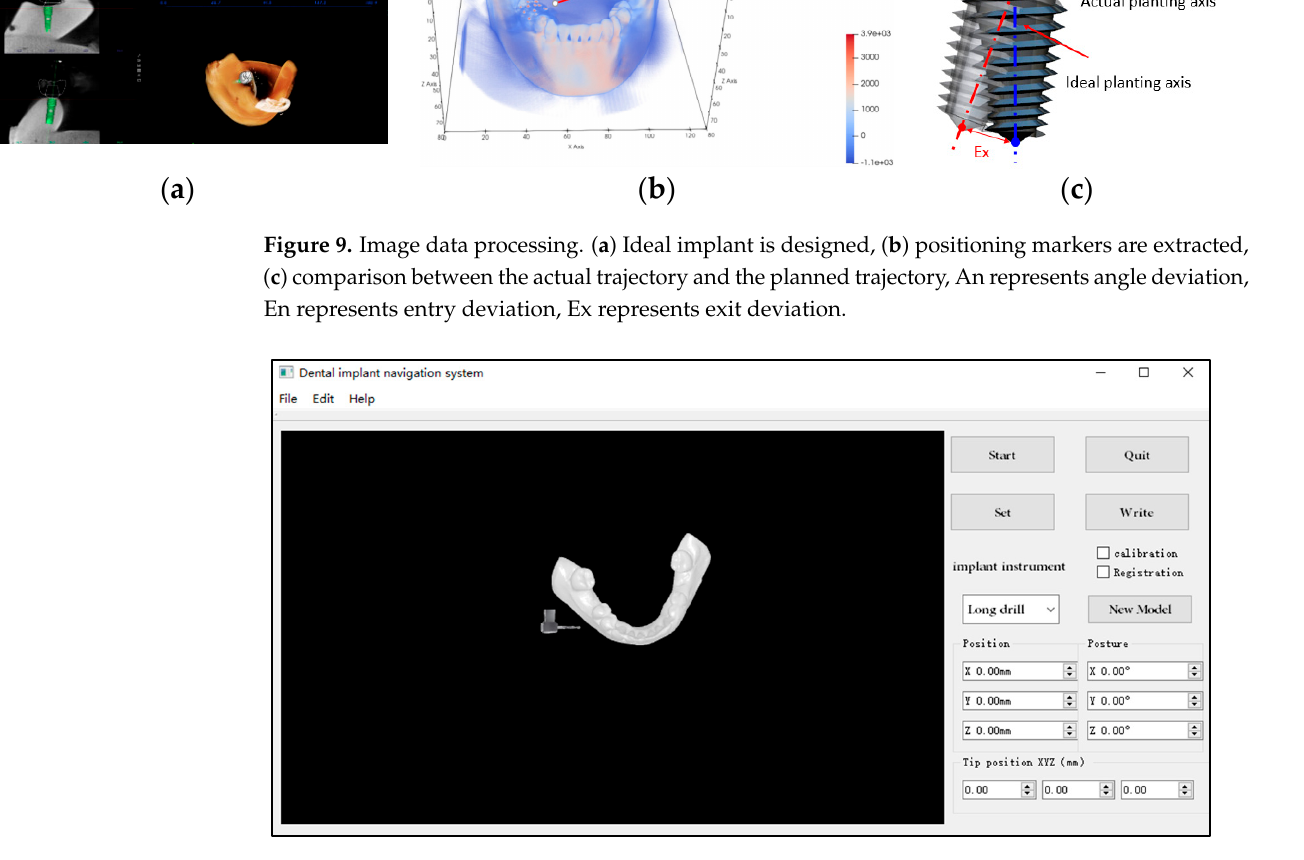
Figure 10. The dynamic real-time representation on the computer.